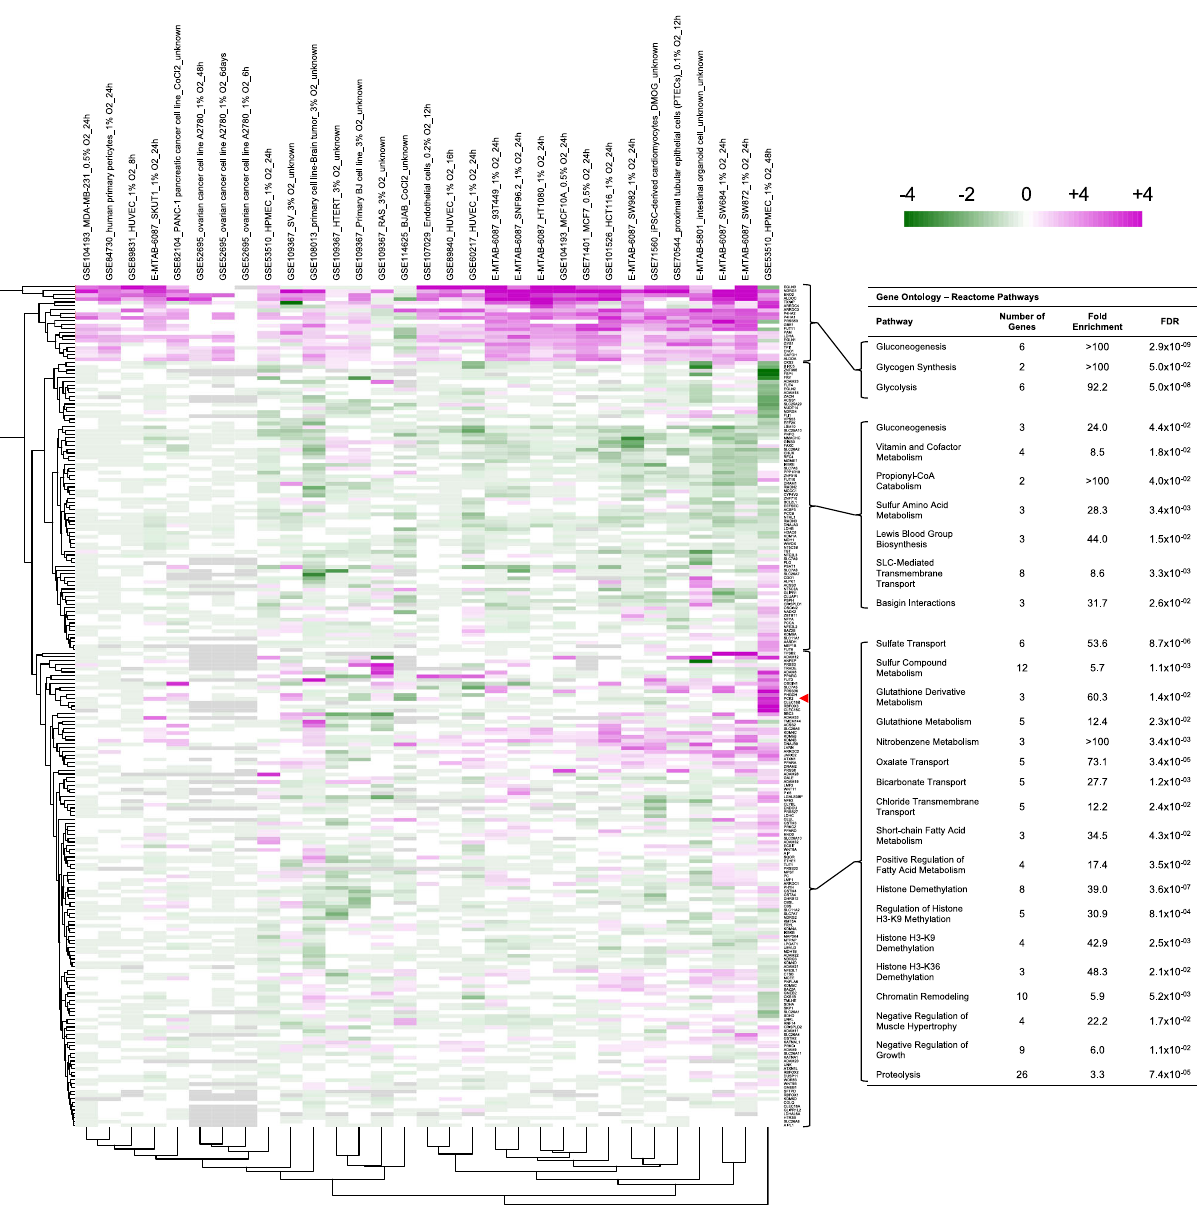
clustered. Clusters of genes were analyzed for GO Reactome Pathway enrichment. While a cluster of genes (top of map) that were enriched for glycolysis and gluconeogenesis GO and reactome annotations showed near- universal upregulation across all the experiments, most putative orthologs clustered based on shared context- or tissue-dependent expression, including PCK2 (red arrowhead), an ortholog of pck-1 . These latter clusters were enri- ched for sulfur and glutathione metabolism, metabolite transport, and chro- matin modi fi